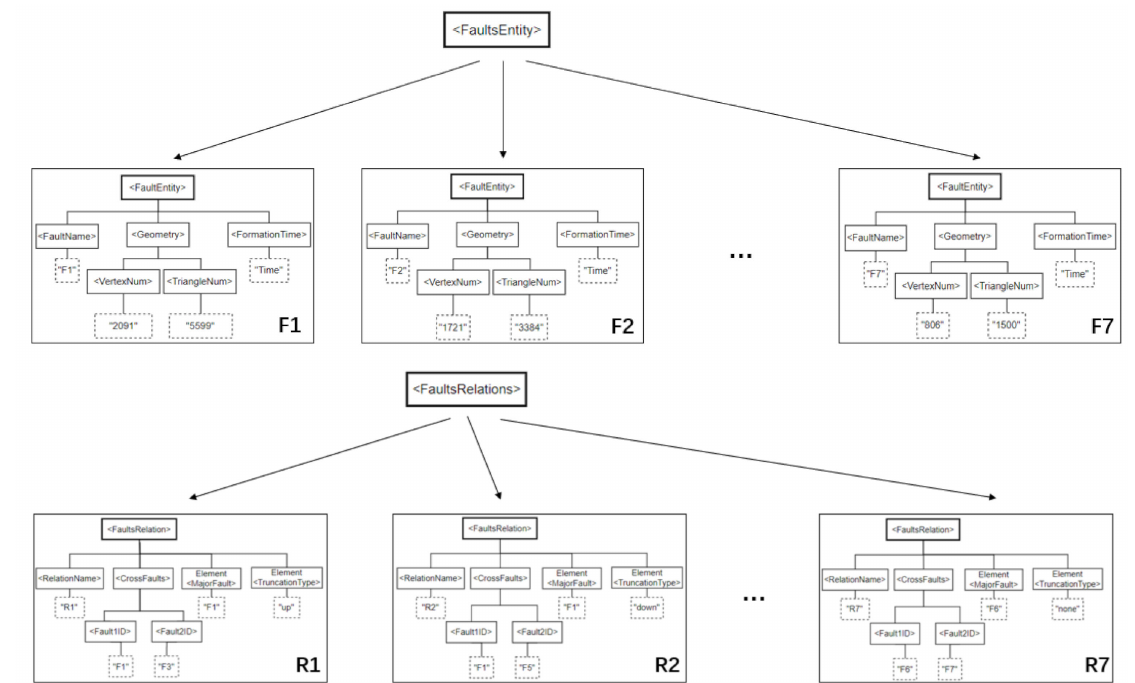
Figure 19. Schematic diagram of XML record result.